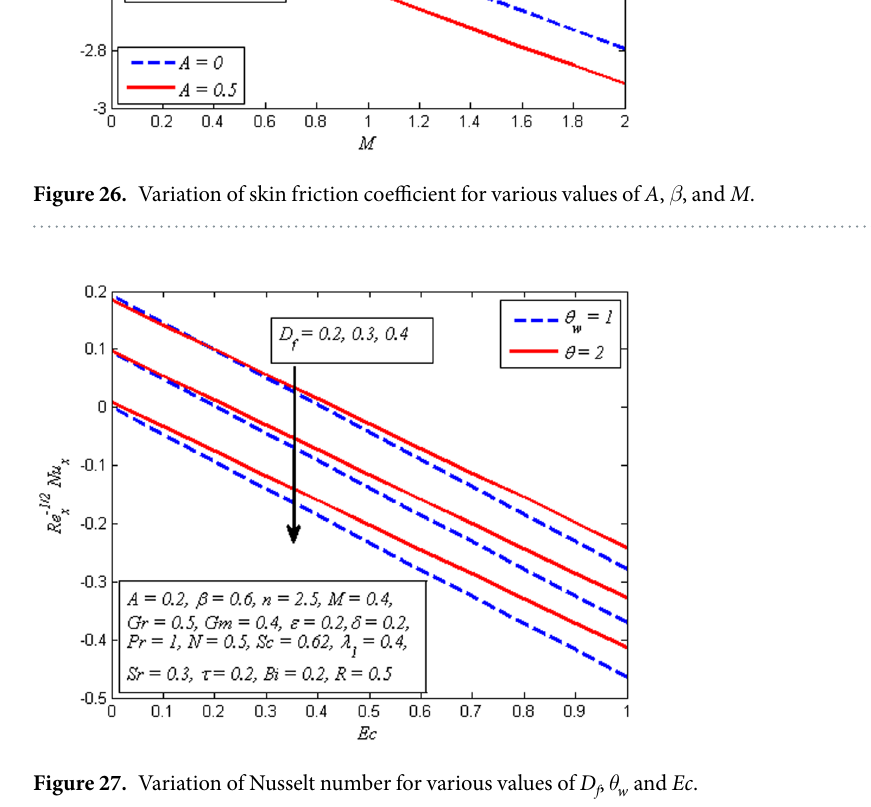
Figure 27. Variation of Nusselt number for various values of D f , θ